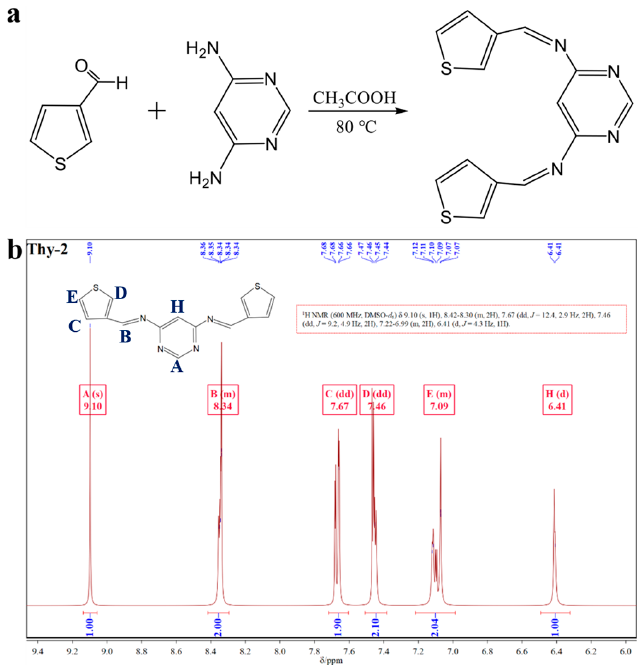
Figure 1. ( a ) Synthesis route of Thy-2 corrosion inhibitor; ( b ) 1 H-NMR spectrum of Thy-2 inhibitor